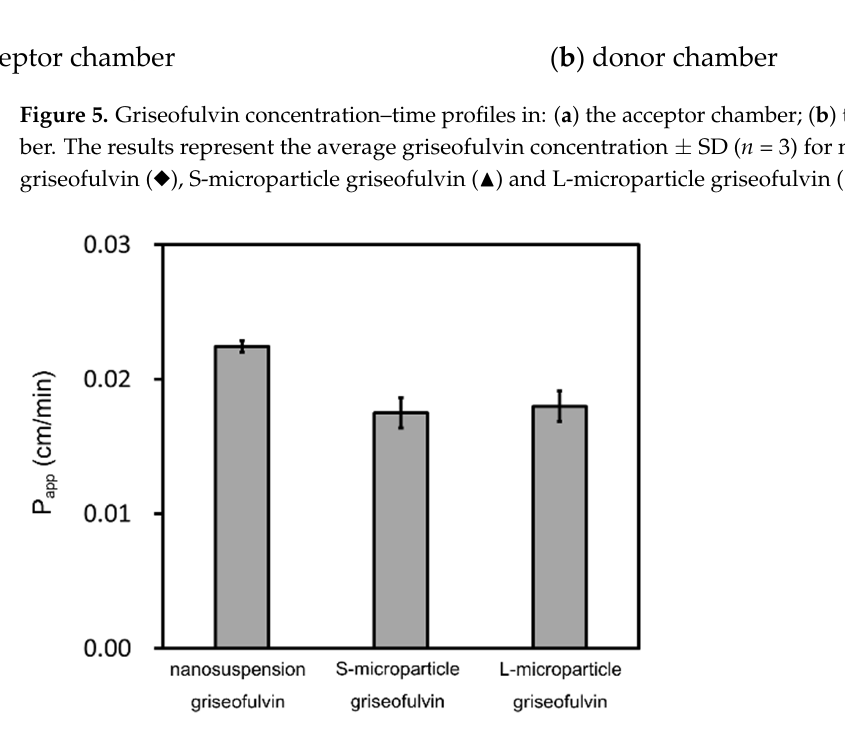
Figure 6. Calculated apparent permeability (P app ) of griseofulvin. The results represent the average P app ± SD ( n = 3).